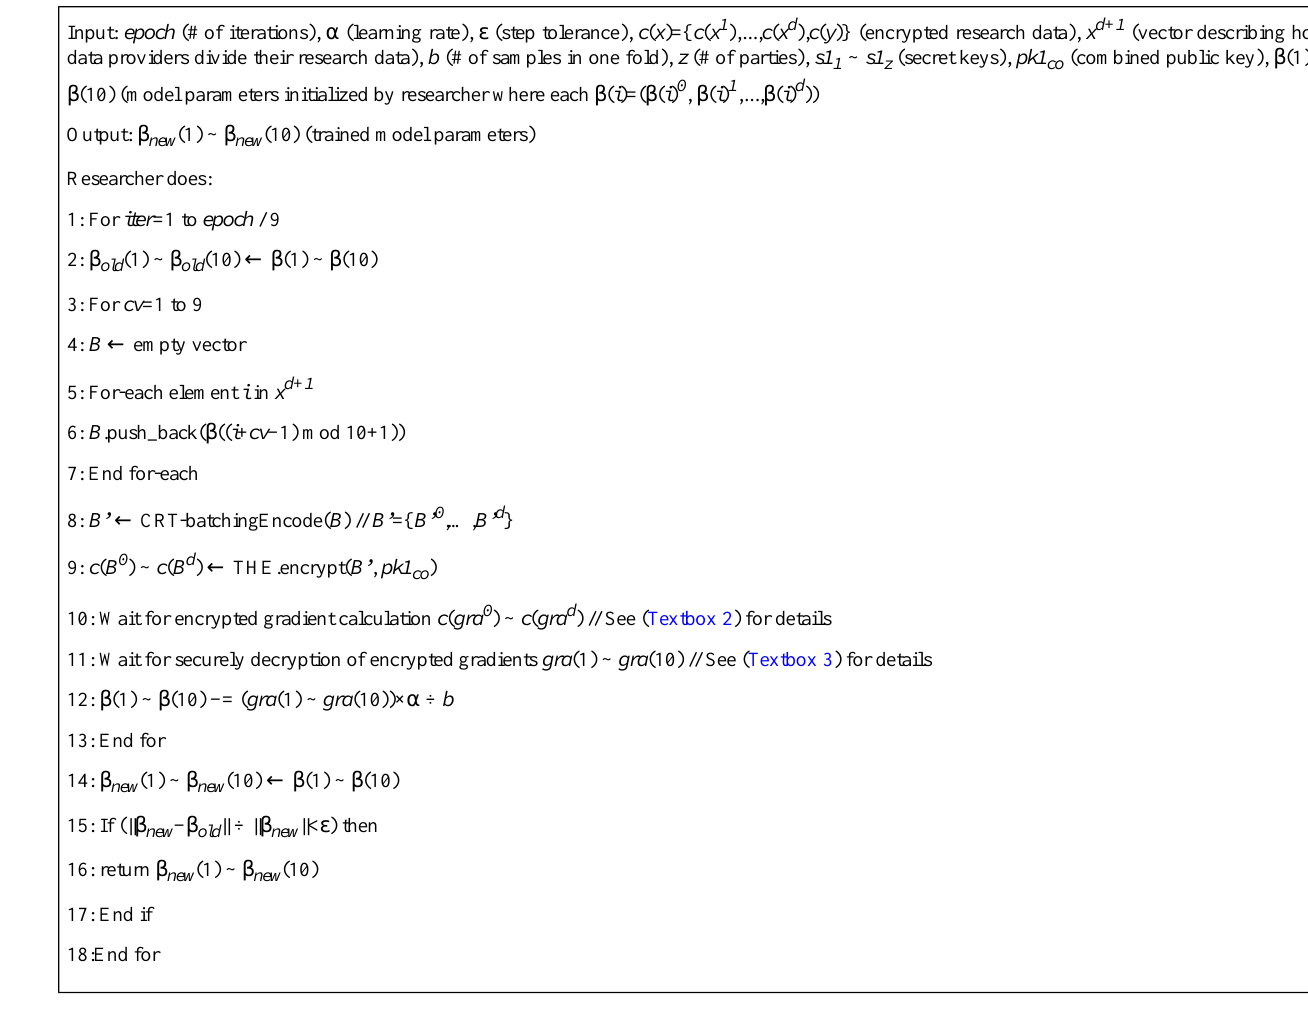
Textbox 1. Privacy-preserving logistic regression model